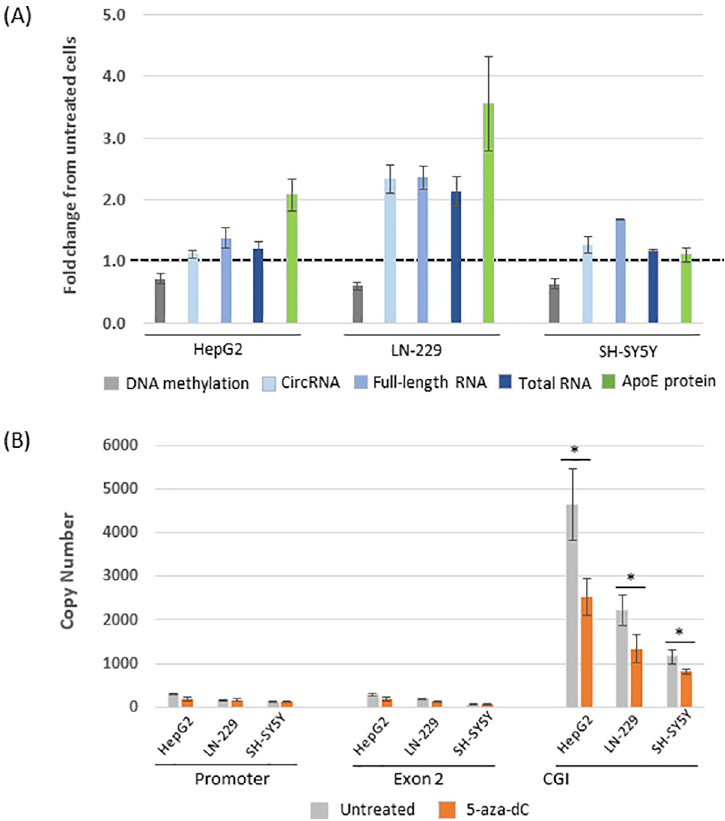
Fig 6. Effects of DNA methylation, RNA/protein production, and protein binding in 5-aza-dC treated cell lines HepG2, LN-229, and SH-SY5Y. (A) Comparison of APOE DNA methylation and APOE RNA expression and secreted ApoE levels in 5-aza-dC treated cells. Levels from treated cells are plotted as fold change when compared with their untreated counterparts (set at 1.0, dashed line). The DNA methylation levels at the APOE CGI were quantified using bisulfite pyrosequencing. The expression levels of APOE RNAs (circRNA, full-length RNA, and total RNA) were quantified by qRT-PCR using TaqMan assay. The expression levels of secreted ApoE proteins were quantified by ELISA. (B) Binding of MECP2 protein in three APOE gene regions (promoter, exon 2, and CGI) between 5-aza-dC treated and untreated cells using ChIP-qPCR. Error bars represent three independent assays. � : t-test, p < 0.05. CGI: CpG island; circRNA: circular RNA; qRT-PCR: quantitative reverse transcriptase polymerase chain reaction; ChIP: chromatin immunoprecipitation. ELISA: enzyme-linked immunosorbent assay. DNA methylation levels at APOE DMR 1 using pyrosequencing, and quantified APOE RNA levels by quantitative RT-PCR (qRT-PCR) using TaqMan assay. In parallel, we quantified secreted levels of ApoE in cell culture medium using an ELISA. For these analyses, two inde- pendent cultures were used for bisulfite pyrosequencing, three independent qRT-PCR assays were performed, and media from three independent cultures (per cell-type and treatment combination) was assayed by ELISA. Average and standard deviation of these multiple assays are calculated and fold change of levels of 5-aza-dC treated cells compared to those of untreated cells (set at 1.0 for untreated) are used for plotting in Fig 6A. We observed a marked reduction (28 to 40%) of methylation at DMR 1 for the treated cells compared to the untreated cells (Fig 6A). This decrease in DNA methylation was consistently associated with increased production of APOE RNAs (circRNA, full-length mRNA, and total RNA). Increase in APOE RNA production after 5-aza-dC treatment is confirmed with increased production of ApoE protein compared to the untreated cells. Very low expression of APOE gene in neuron cells is likely to account for almost no increased production of ApoE